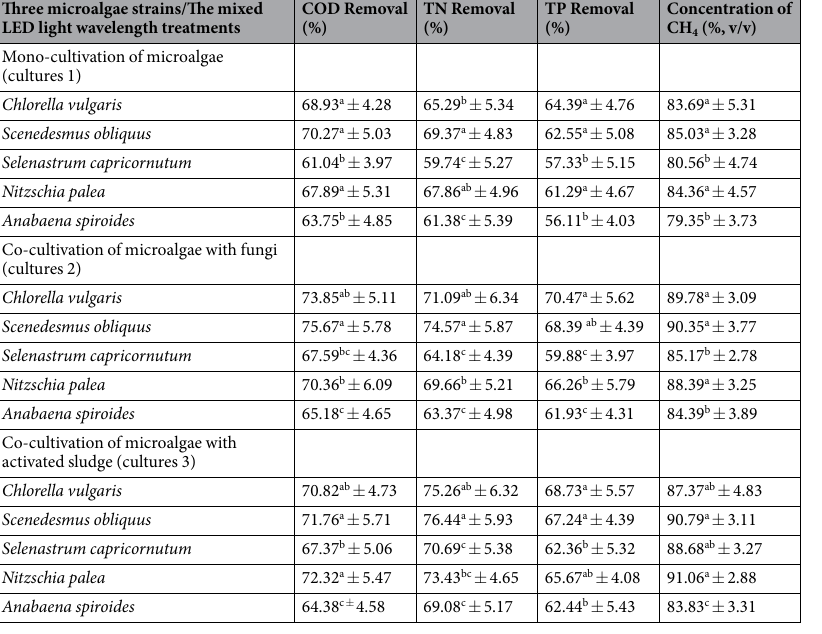
Table 2. COD, TN, and P removal efficiencies and CH 4 concentration in the upgraded biogas during the operational period evaluated. Note: Values with different superscript letters for the same microalgae cultivation technology indicate a significant difference at P < 0.05 according to the Duncan’s multiple range